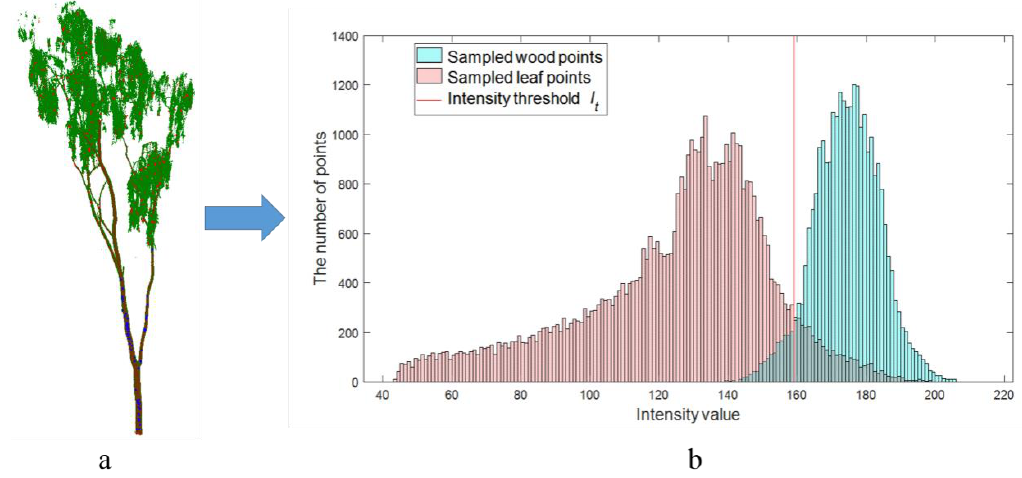
Figure 7. Demonstration of sampling results and intensity threshold based on tree 5. ( a ) The sampling results of tree 5. ( b ) Intensity histograms of the sampling results. Cyan areas and pink areas represent the intensity histograms of the sampled wood and leaf points, respectively. The red line represents the selected adaptive intensity threshold.